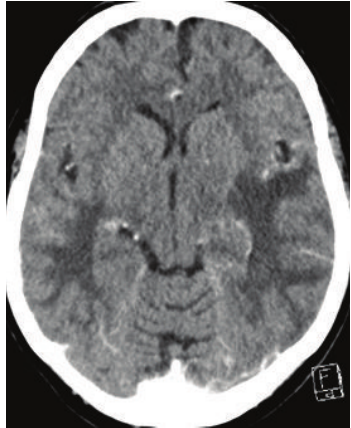
Figure 1: Contrast enhanced CT brain showing bilateral vasogenic edema of the parietal and temporal